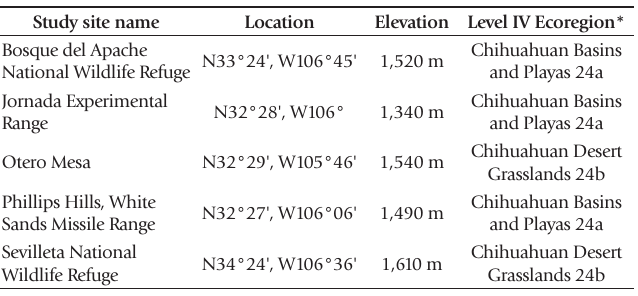
Table 1. Study site information based on center of each site.